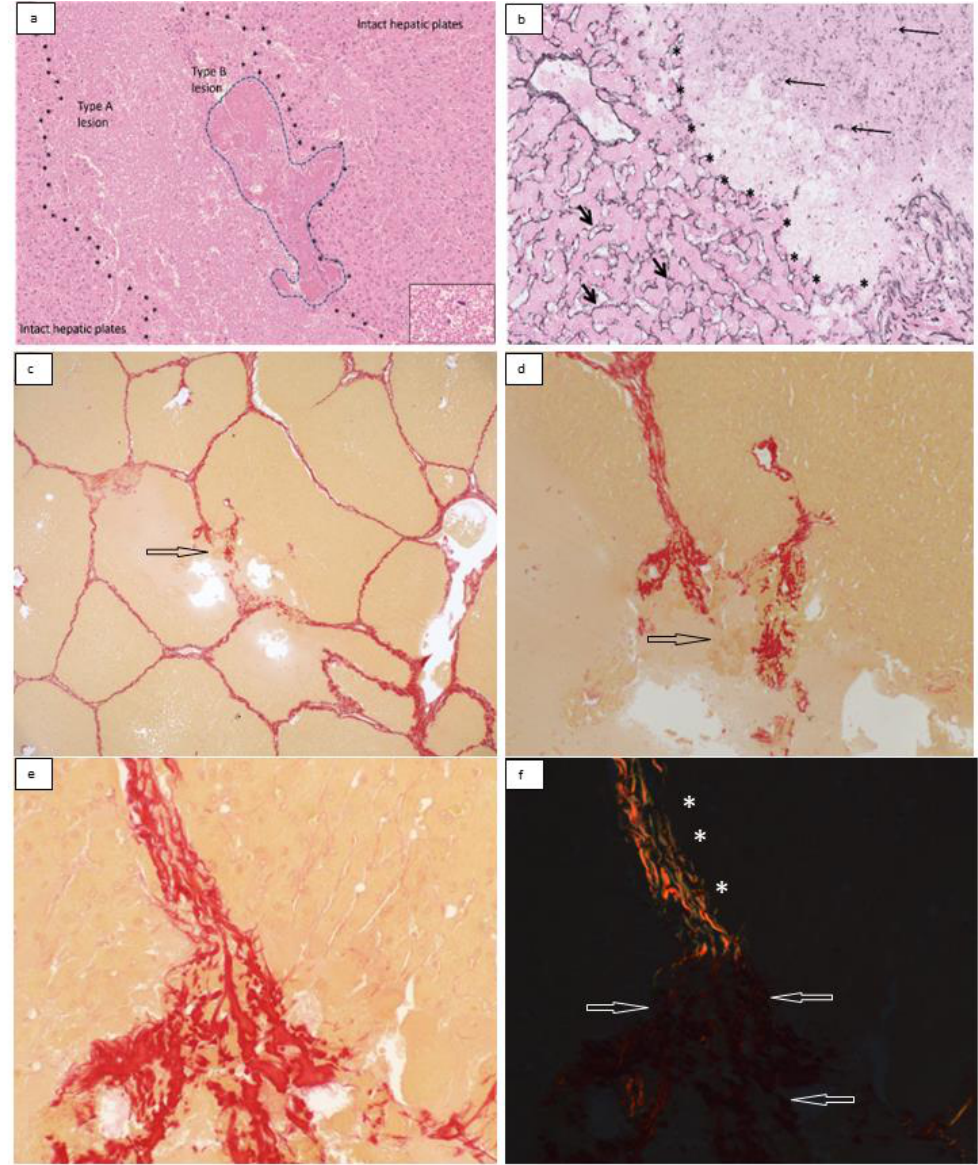
Figure 4. ( a ) H&E: type A and B lesions. Nuclear debris and scattered nuclei were present in type A lesions ( a, inset). ( b ) Reticulin stain: loss and fragmentation of reticulin fibers (long thin arrows) at lesional site. Please note sharp transition (asterisks), with nearby preserved hepatic plates showing an intact reticulin framework (short arrows). ( c – f ) Picro – Sirius red stain. ( c , d ) A broken interlobular septum is shown at lower ( c , arrow) and higher ( d ) magnification. ( e , f ) show retention (asterisks) and loss (arrows) of collagen birefringence in type C and type D lesions, respectively.